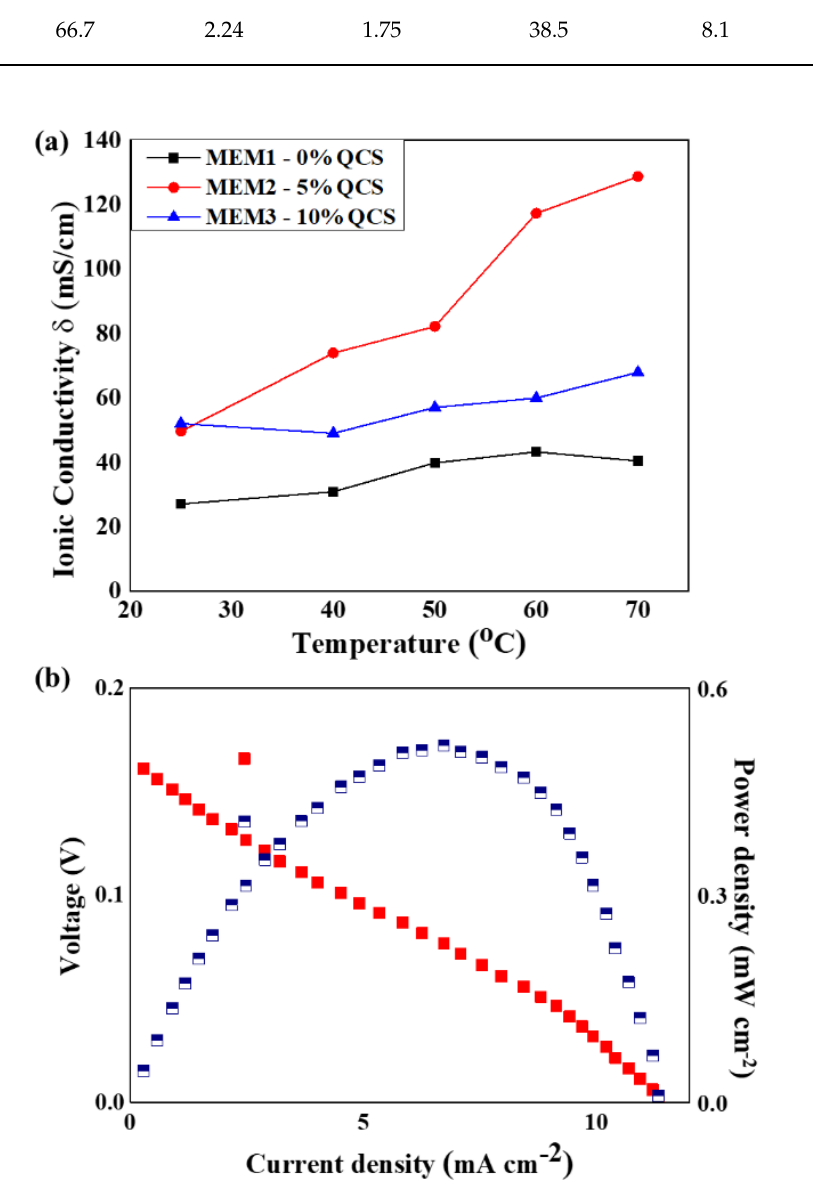
Figure 10. ( a ) Ionic conductivity with variation in temperatures for different membranes; ( b ) urea/O 2 test result for MEM2, combined fuel cell I-V (red cubes) and power density curve (blue cubes). Table 1. Properties of membranes.